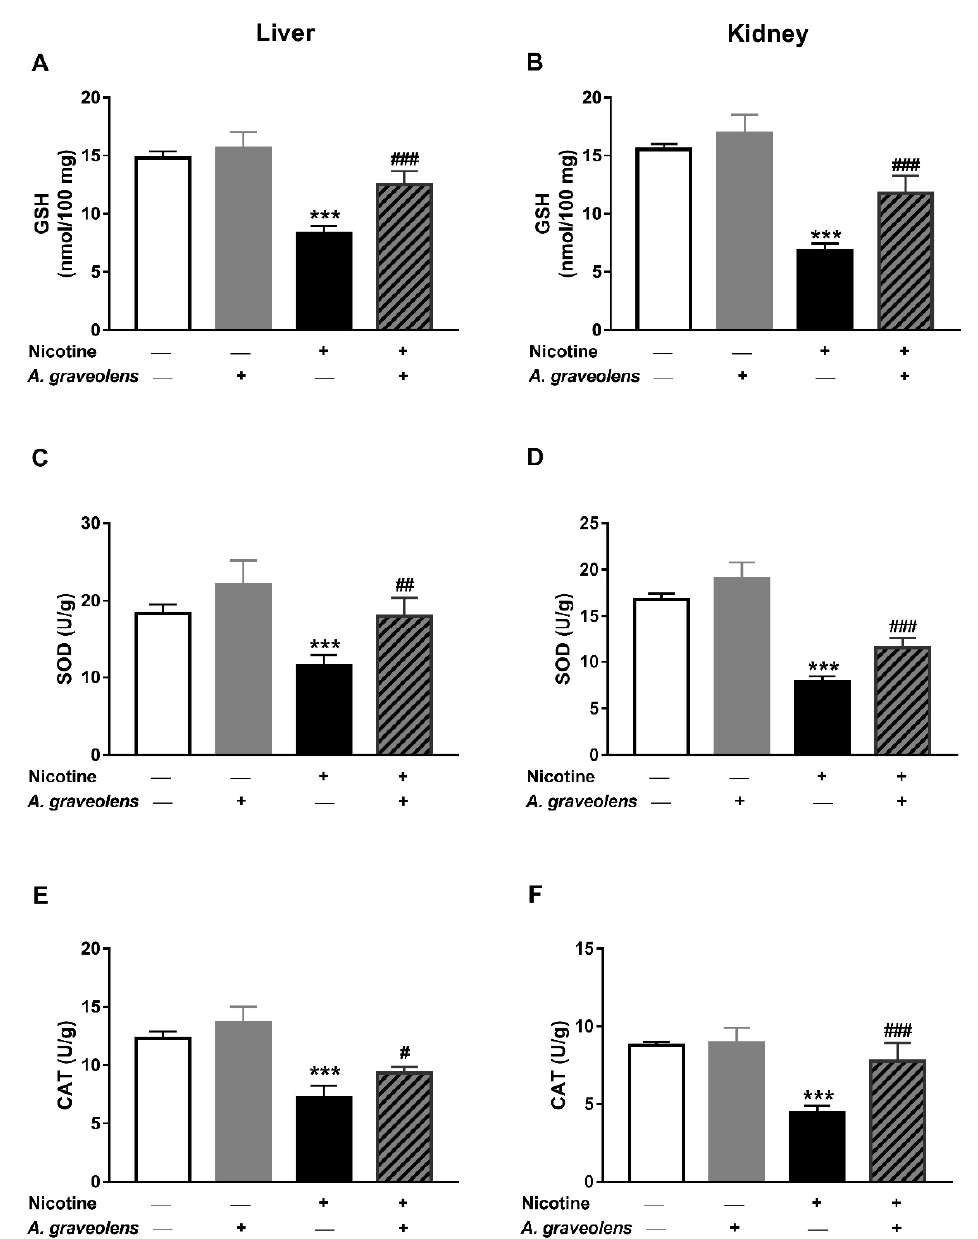
Figure 6. A. graveolens and increased glutathione (GSH), superoxide dismutase (SOD) and catalase (CAT) in liver and kidney of nicotine-exposed mice newborns. Data are mean ± SEM, n = 8. *** p < 0.001 versus Control and ### p < 0.001 versus nicotine: ( A ) Liver GSH; ( B ) Kidney GSH; ( C ) Liver SOD; ( D ) Kidney SOD; ( E ) Liver CAT; ( F ) Kidney CAT.